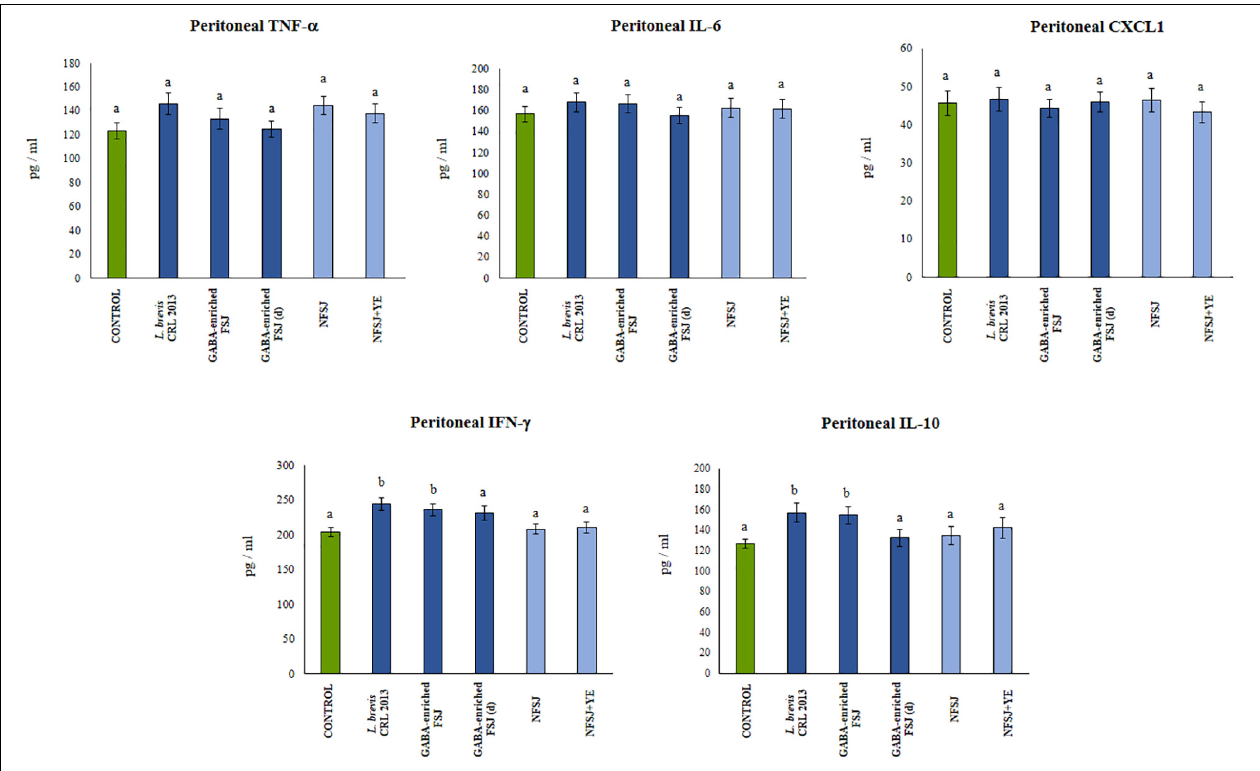
FIGURE 3 | Effect of L. brevis CRL 2013, GABA-enriched strawberry fermented juice (FSJ) and diluted (d) GABA-enriched FSJ on peritoneal cytokines and chemokines in Balb/c mice. Animals treated with NFSJ or NFSJ supplemented with YE were used for comparisons. Results are expressed as mean ± SD. Means for each bar without a common letter differ significantly. Significance with Tukey’s HSD post hoc test following a one-way ANOVA is indicated as p <